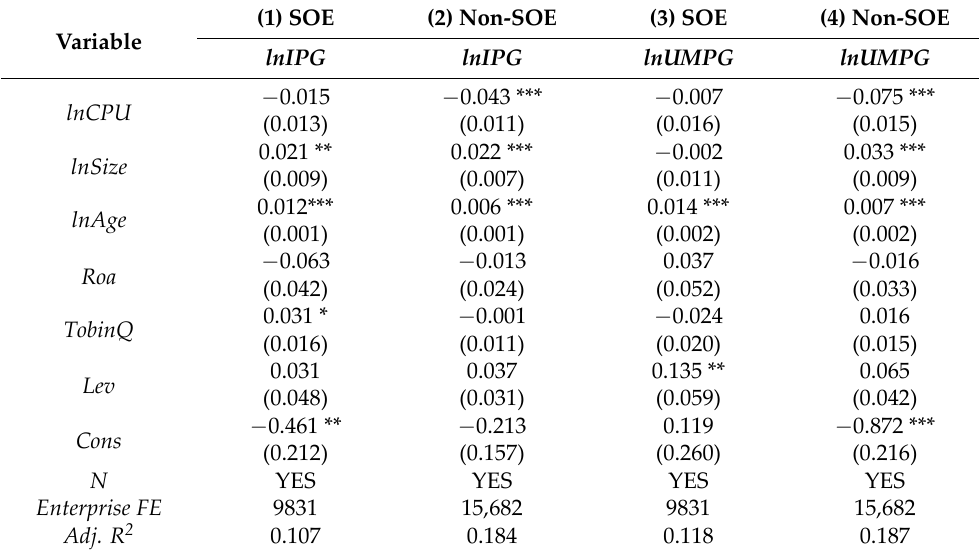
Table 7. Heterogeneity